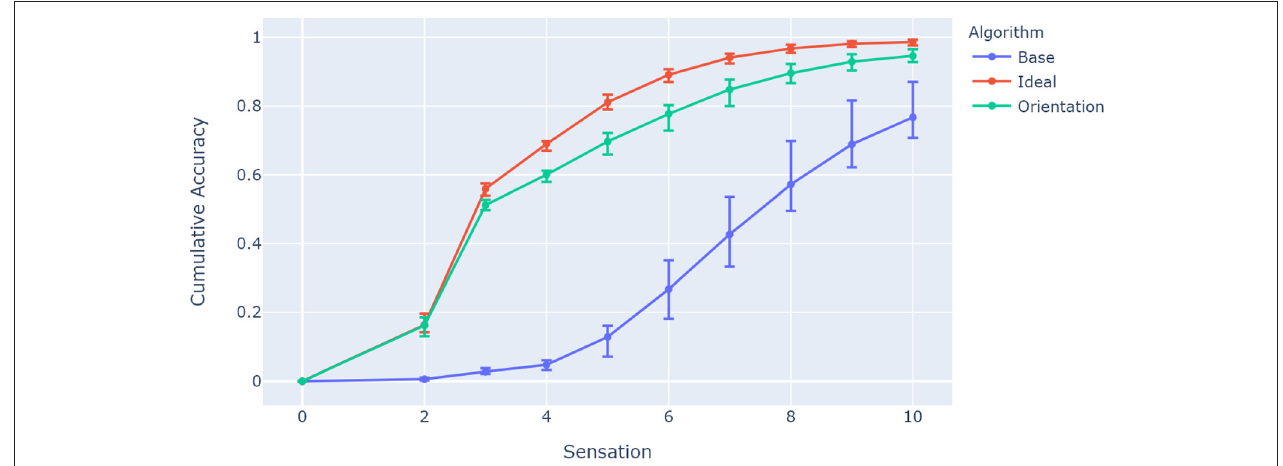
FIGURE 6 | Comparison between algorithms showing model accuracy for 25 grid cell modules and 13 cells per axis. The experiment was repeated 10 times, with the 5th, 50th, and 95th percentiles shown. The base algorithm represents a network with no orientation capabilities, while the ideal algorithm has prior knowledge of the ideal equivalent orientation of its location layer for each object. The accuracy has been tested for 1,000 random rotations from a training pool of 50 objects, and accumulates over 10 sensations as more objects are recognized. The proposed algorithm ( M = 0.948, SD = 0.014) has comparable accuracy to the ideal model for the given parameters, and improves significantly from the baseline case ( M = 0.780, SD = 0.0596), t (9) = 11.46, p < 0.0001.